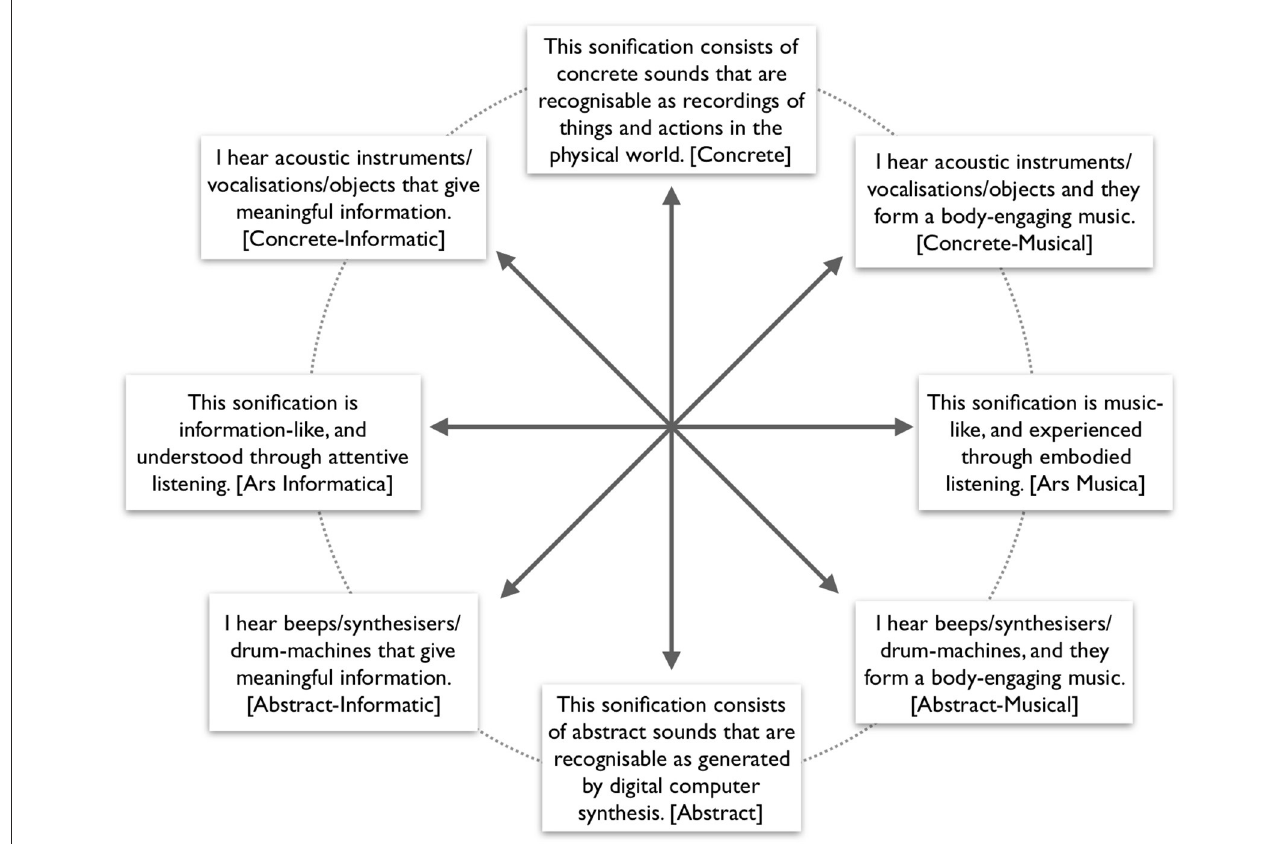
FIGURE2 Eight statements of perceived characteristics spanning the Aesthetic Perspective